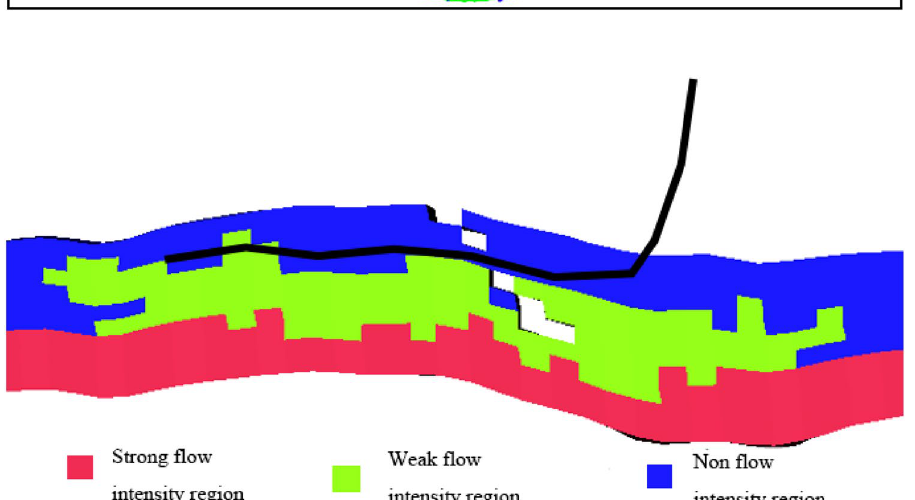
Fig. 17 Diagram of a new hori- zontal well based on flow field